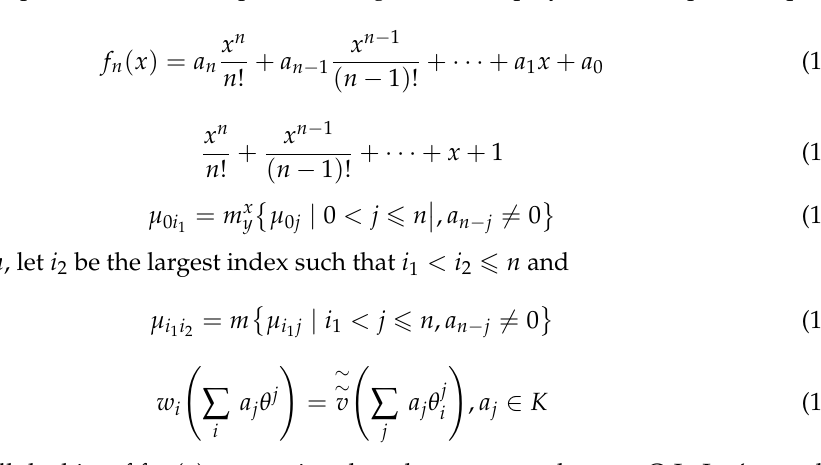
Figure 4. Basic AES 128-bit block diagram.